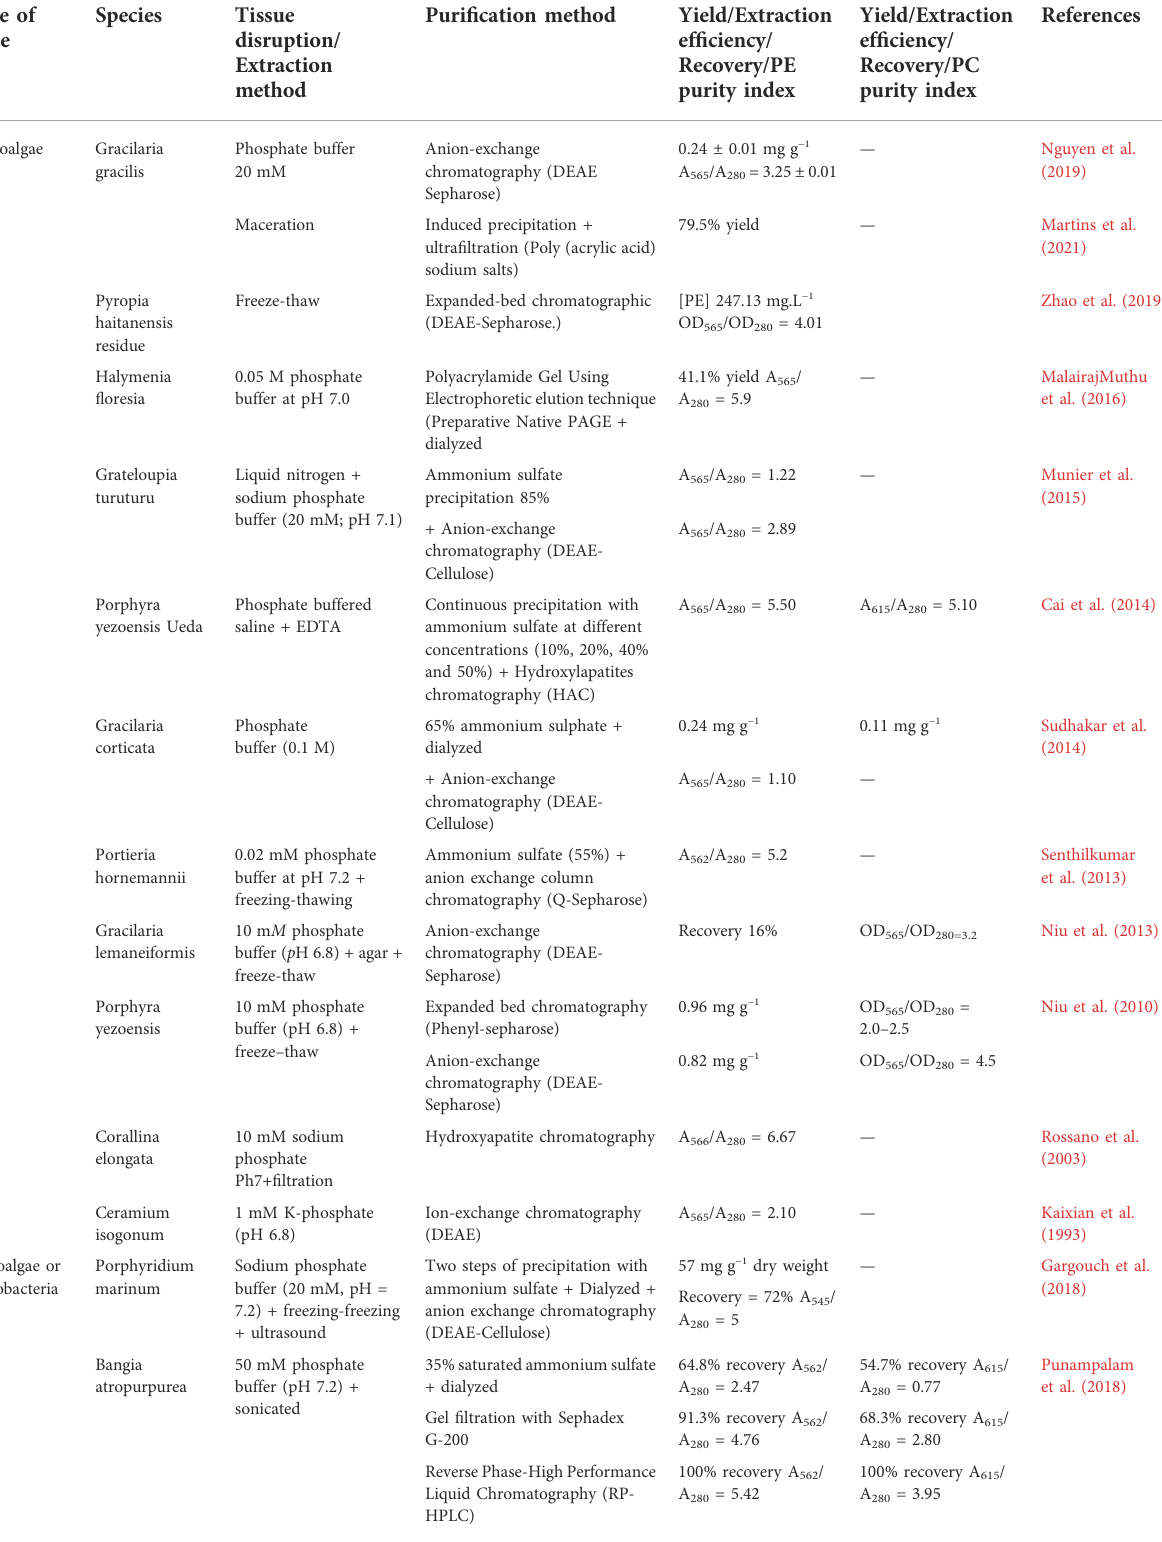
TABLE 4 Puri fi cation methods applied to the fractionation of